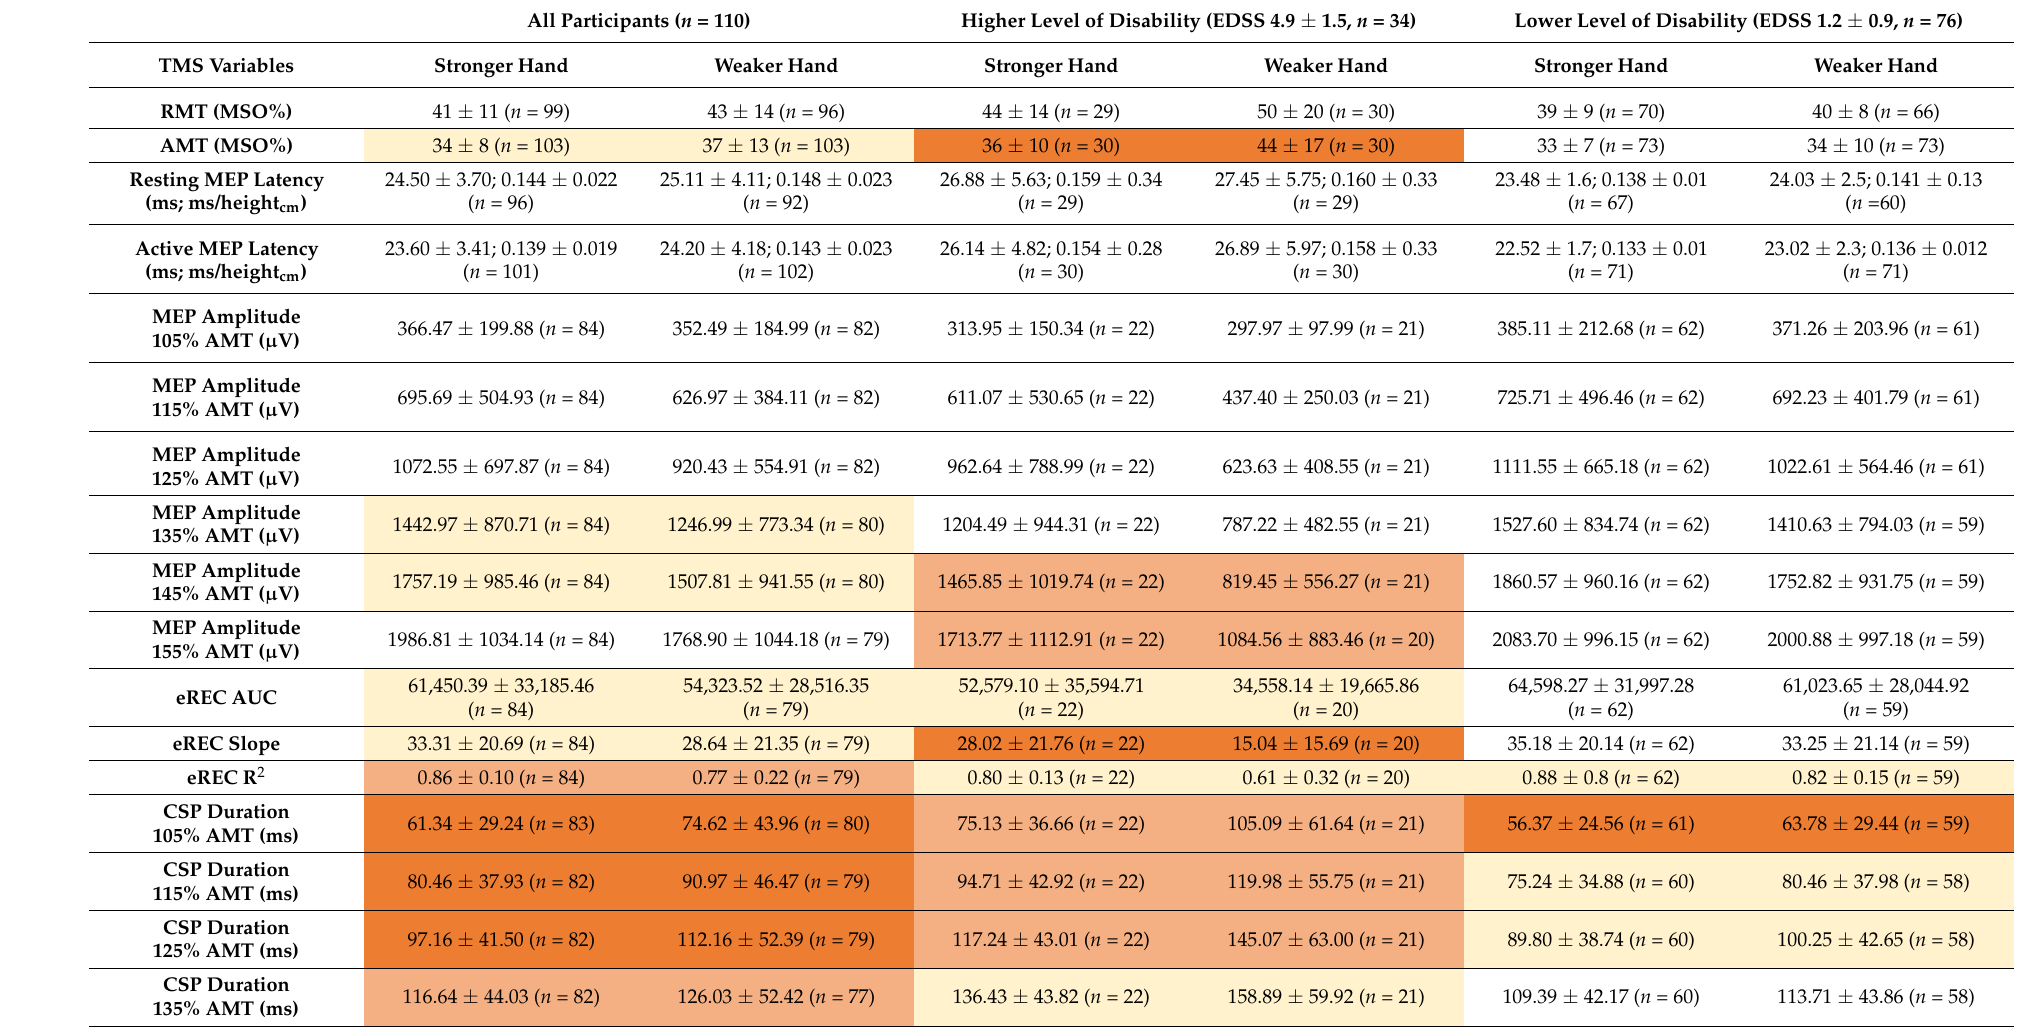
Table 2. Differences in TMS variables between